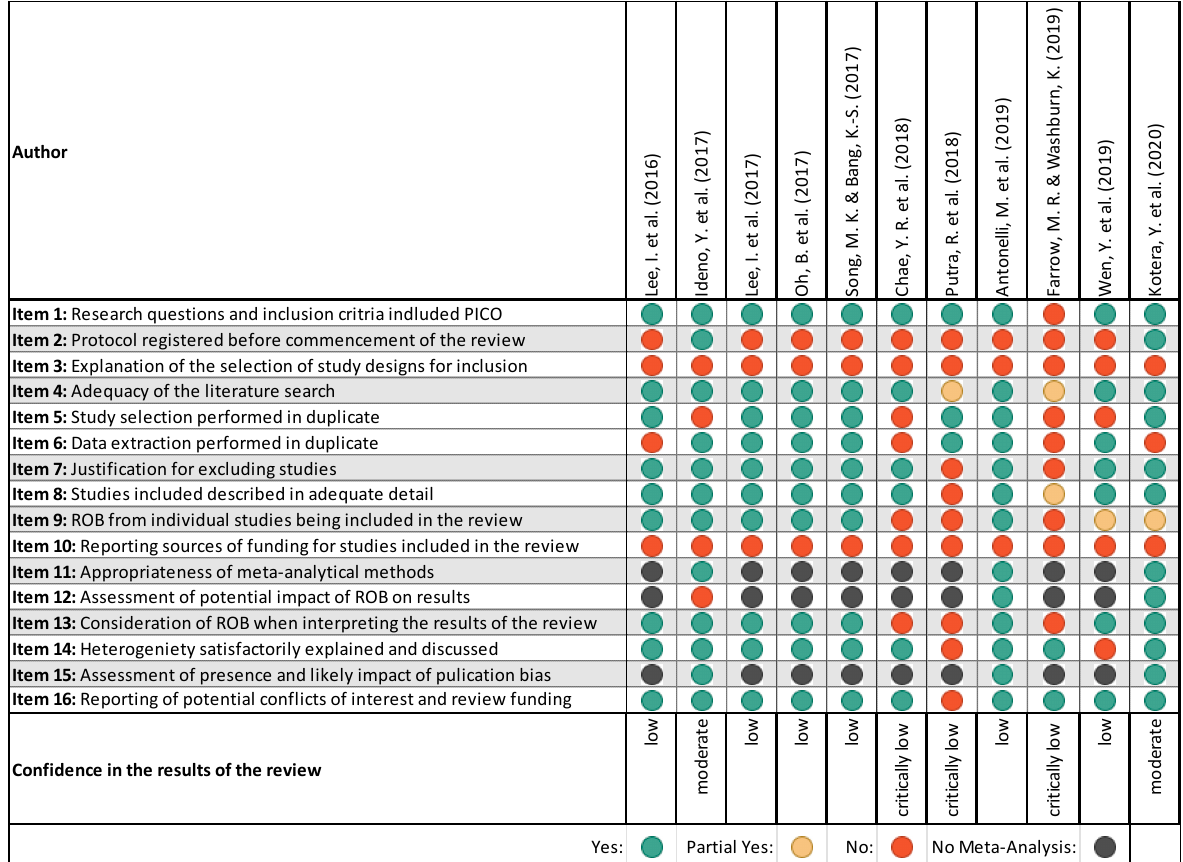
Figure 3. Quality assessment of included reviews based on AMSTAR-2. Critical domains are highlighted in grey. RoB: risk of